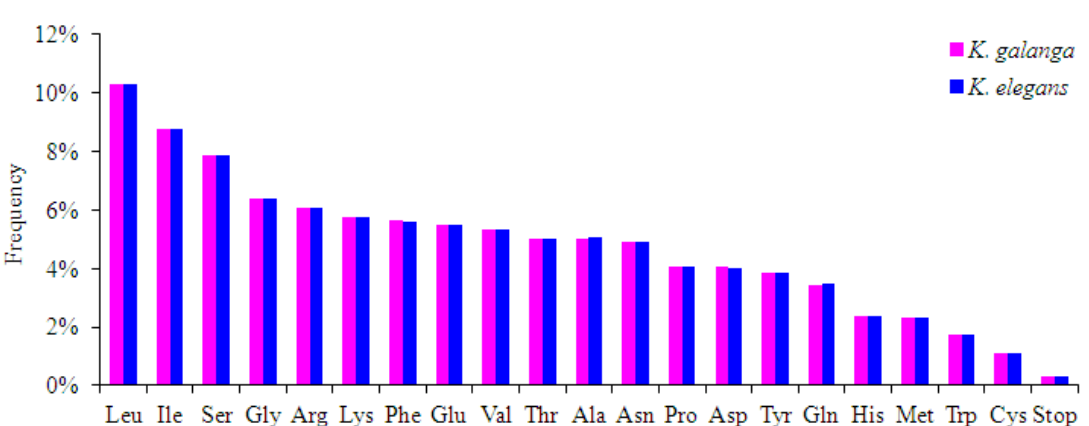
Figure 2. Amino acid frequencies in K. galanga and K. elegans protein-coding sequences.